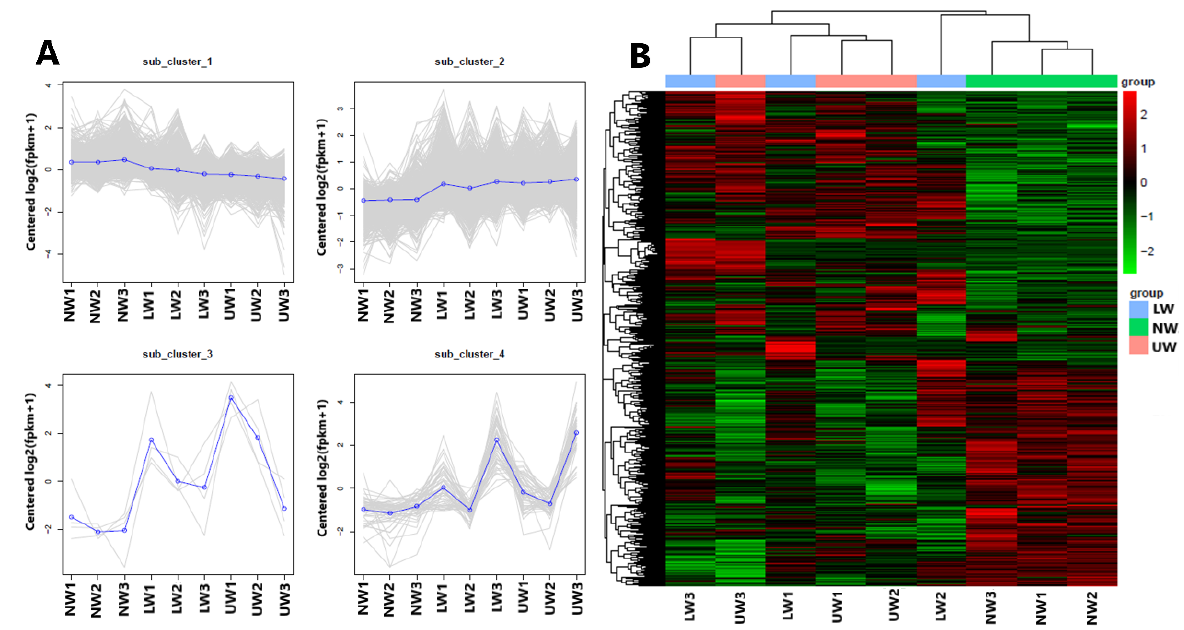
Figure 2. Results from multivariate analysis. ( A ) The first four principal components and distribution of genes in these clusters, and ( B ) clustering heat map of differentially expressed genes in different wood samples.